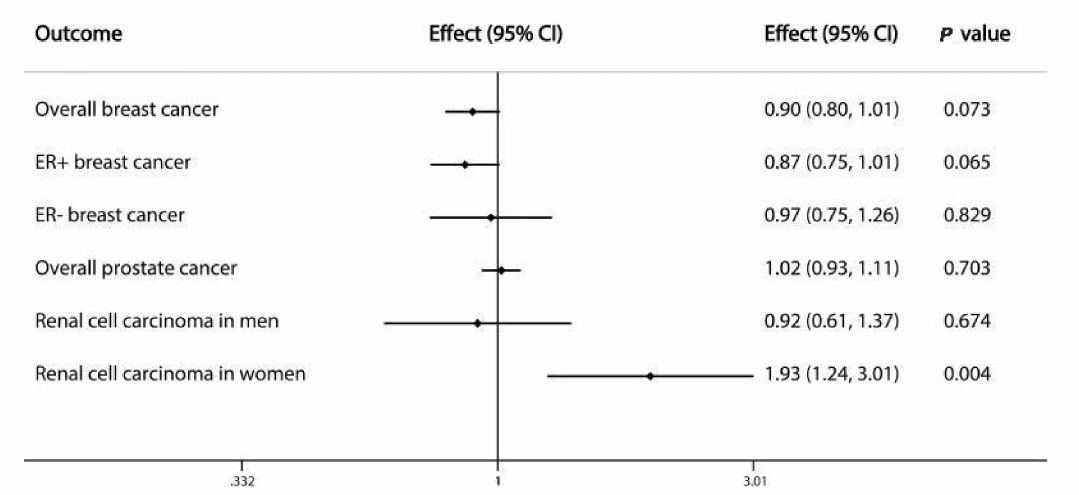
Figure 2. Forest plot of causal associations of serum urea on overall BRCA, overall PCa and RCC in female and male. Effect: The causal association; 95% CI: 95% confidence interval; p -value: the significance of the instrumental